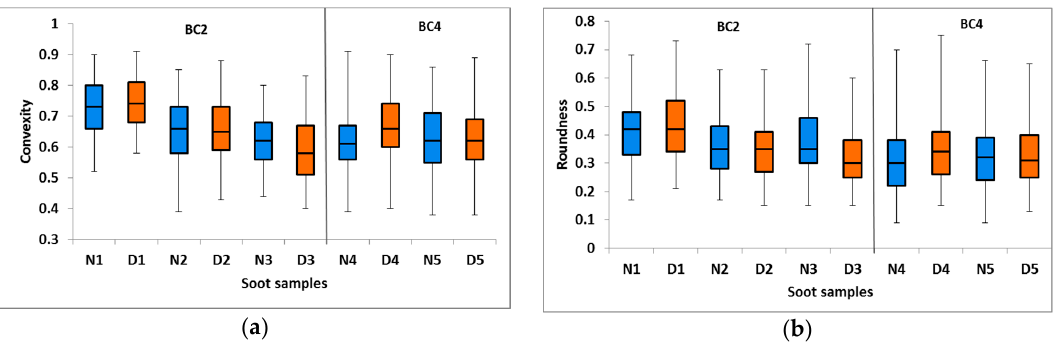
Figure 5. Box and whisker plots of ( a ) convexity and ( b ) roundness. Blue boxes represent the nascent soot and orange boxes represent the nascent-denuded soot. The horizontal bar inside the box represents the median value while the lower part and upper part of the box separated by the horizontal bar represent the first and third quartiles, respectively. The lower and upper extremities of the whiskers represent the minimum and maximum values, respectively.